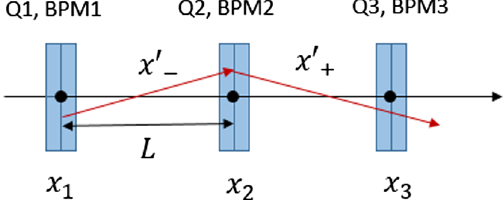
FIG. 1. Layout of BPMs and quadrupoles in the LCLS Linac.